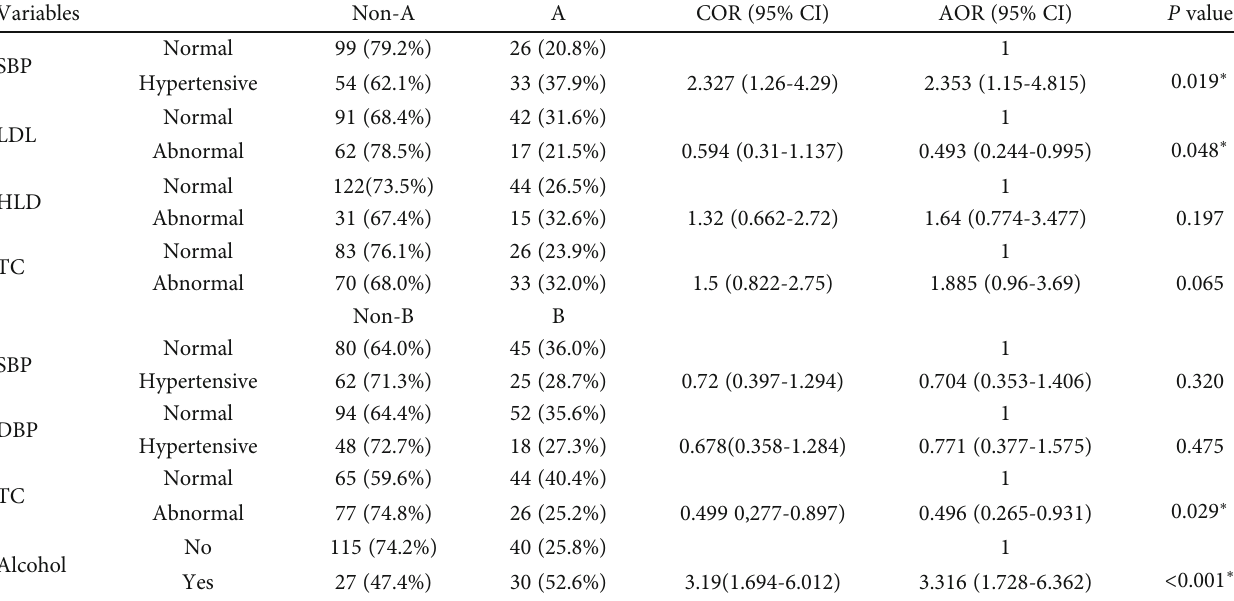
Table 4: Association of ABO blood group phenotypes with biochemical and anthropometric measurements at FHCRH, Bahir Dar, northwest Ethiopia 2019 (n